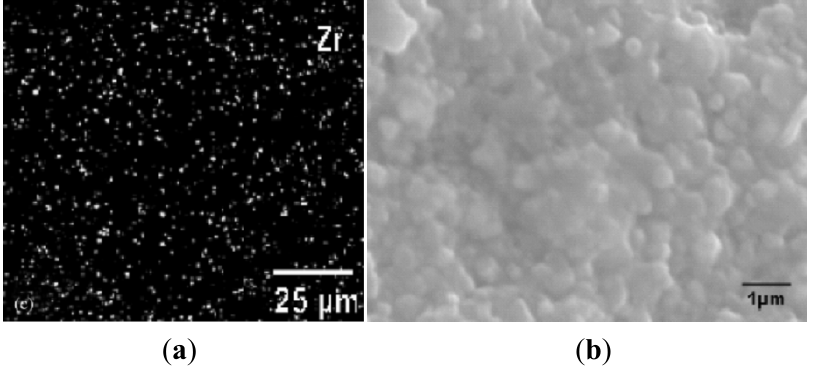
Figure 16. ( a ) X-ray mapping of Zr carried out using EPMA on the wear-scar of 6 wt% ZrO particle reinforced WC nanocomposite after fretting at 10 N load for 100,000 cycles; 2 and ( b ) SEM of the fracture surface of the nanocomposite densified using SPS at 1300 °C for 5 min